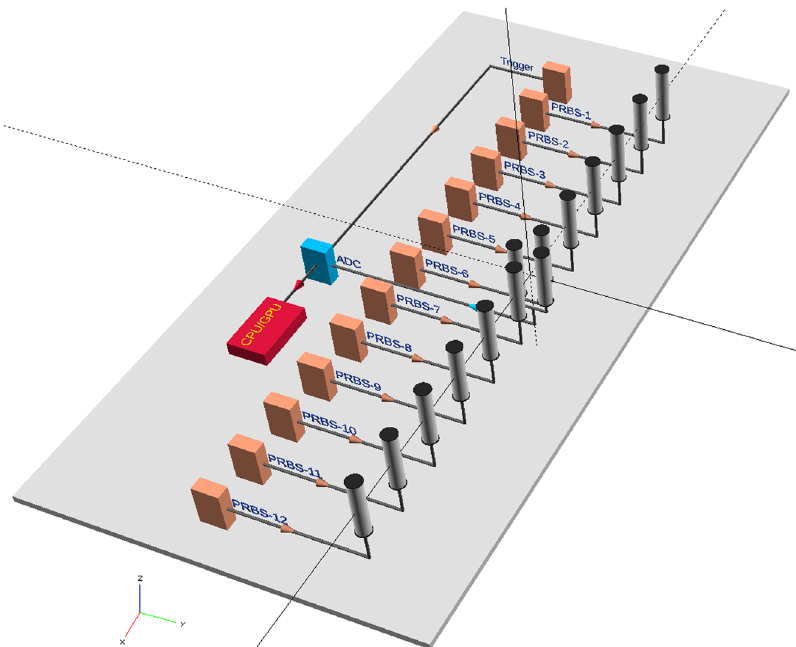
Fig. 3 Experimental setup. Schematic showing the pseudo-random binary sequence (PRBS) generators that feed the antenna array after an ampli fi cation stage (not shown). The transmitter array comprises 12 omni-directional antennas each receiving a unique PRBS code. The generators are synchronized by the trigger source also used to time align the analog-to-digital converter (ADC). The differential receiver comprises two omini-directional antennas connected by a 180-degree transformer and ampli fi cation stage (not shown). The ADC digitizes the signal from the ampli fi ed transformer output and stores it in a local buffer. The computer (CPU) queries and transfers the digitized capture from the ADC buffer and uploads it to a graphics processing unit (GPU) that performs the image reconstruction.